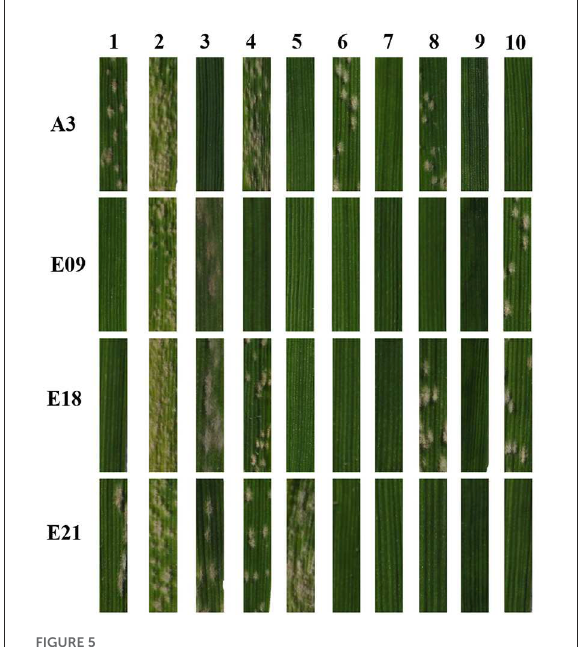
FIGURE5 Reaction patterns of wheat breeding line Yannong 99102-06188 (YN99102) and the resistant donors with cataloged Pm genes on 2BL chromosome to selected Blumaria graminis f. s. tritici isolates A3, E09, E18, and E21. 1: YN99102; 2: susceptible parent Jinhe13-205 (JH13–205); 3: Coker747 ( Pm6 ); 4: Am9/3 ( Pm33 ); 5: CH7086 ( Pm51 ); 6: Liangxing 99 ( Pm52 ); 7: WE35 ( Pm64 ); 8: LS5082 ( PmLS5082 ); 9: KN0816 ( PmKN0816 ); 10: Qingxinmai ( PmQ ).